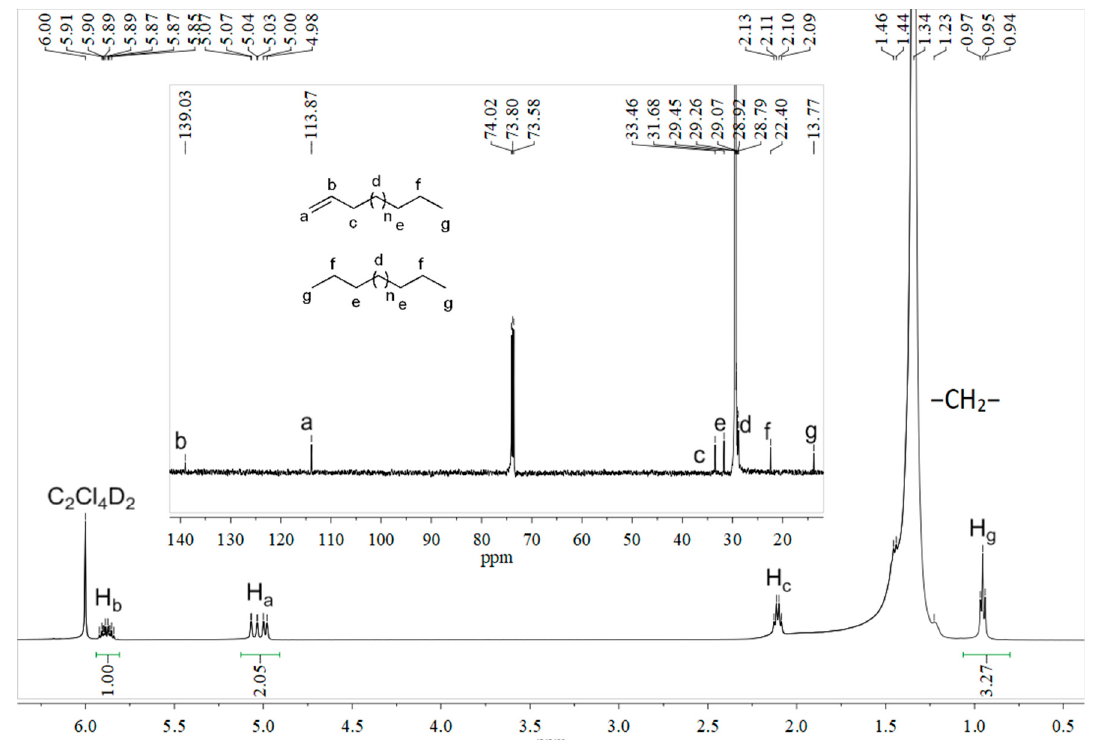
Figure 8. 1 H NMR spectrum of the polyethylene produced using Co2 /MAO at 50 ◦ C (entry 2, Table 3) along with an inset of the 13 C NMR spectrum; both spectra recorded at 100 ◦ C in 1,1,2,2- tetrachloroethane- d 2 .